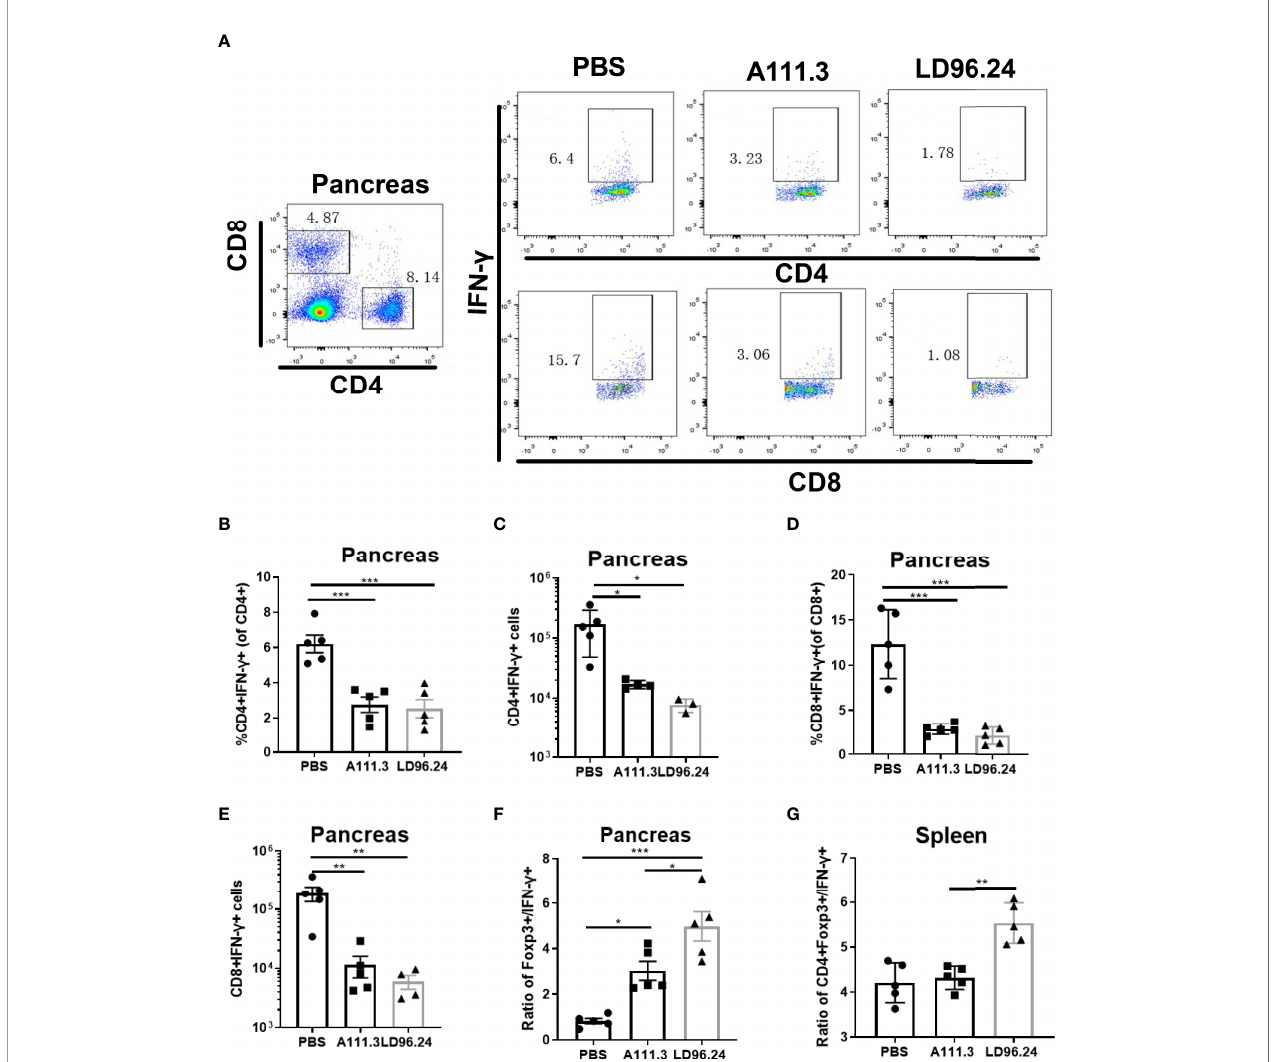
FIGURE 7 | LD96.24-treated mice have an increased CD4 + Foxp3+ to CD4 + IFN- g + T- cell ratio in the pancreas and spleen. Three groups (5 NOD mice/group) were treated weekly from age 4 weeks with PBS, 0.5 mg A111.3 or LD96.24, and pancreatic cells were isolated at age 10 weeks. After stimulation with cell-activation cocktail (cat#: 423301) for 4 h. Cell surface antibodies were stained with BV605-B220, APC eFluor 780-CD8, Alexa Fluor 700-CD4 + , and PerCP-Cy5.5-CD44. Then, intracellular staining with FITC-IFN- g was done using the eBioscience Foxp3/Transcription Factor Staining Buffer Set (Thermo Fisher Scienti fi c) according to the manufacturer ’ s instructions. Stained single-cell suspensions were analyzed using a Fortessa fl ow cytometer running FACSDiva (BD Biosciences). (A) Representative scatter diagram of CD4 + IFN- g + and CD8+IFN- g + in different groups. (B, C) The percentages and cell numbers of CD4 + IFN- g + T-cells in the pancreas. (D, E) The percentages and cell numbers of CD8+IFN- g + T-cells in the pancreas. (F, G) The ratio of CD4 + Foxp3+/CD4 + IFN- g + in the pancreas (F) and spleen (G) . Data are the means ± SEM of each group. Statistical analysis was performed using one-way ANOVA with Tukey ’ s multiple comparison test. *P < 0.05, ** P < 0.001, *** P <